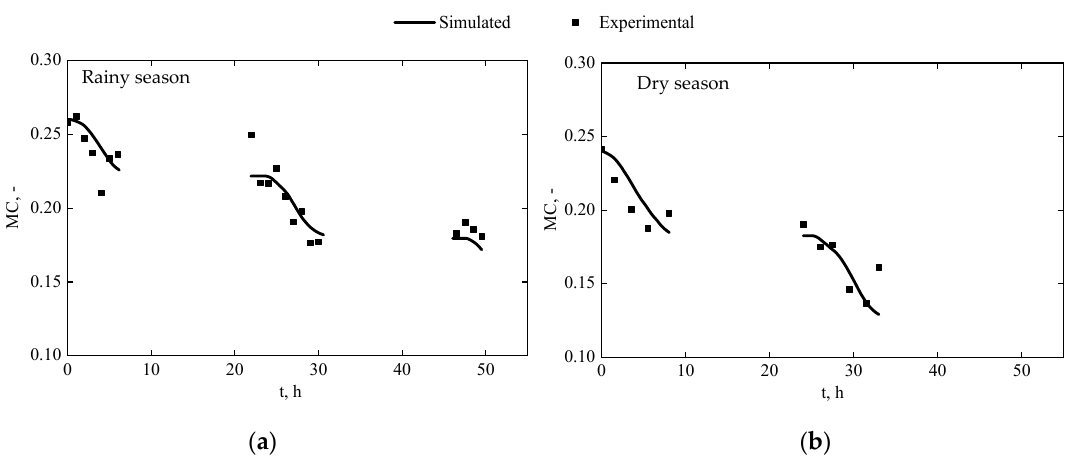
Figure 11. Experimental and simulated moisture content MC during the rainy season (22 November 2012) ( a ) and dry season (4 June 2012) ( b ). Table 3. Coefficient of determination R 2 of air temperatures T ae and instantaneous mass m t at a constant albedo (C) of α pa = 0.1957 and variable (V) albedo α pa .